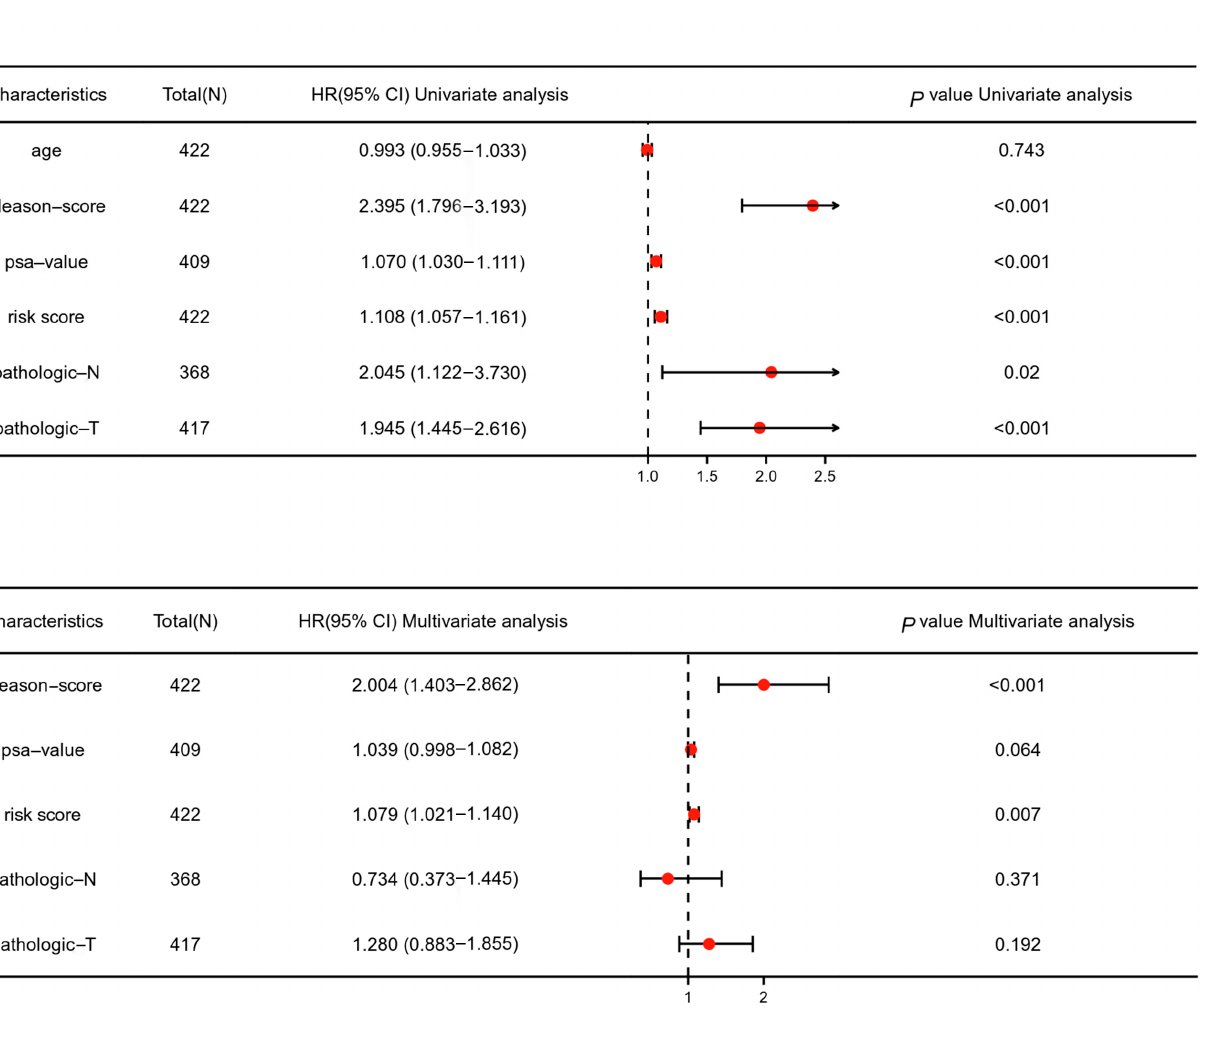
Figure 5. The univariate and multivariate Cox regression analysis of clinical characteristics and risk score. ( A ) Univariate analysis of age, Gleason score, PSA value, risk score and pathological T and N stages. ( B ) Multivariate Cox regression analysis of Gleason score, PSA value, risk score and pathological T and N stages.